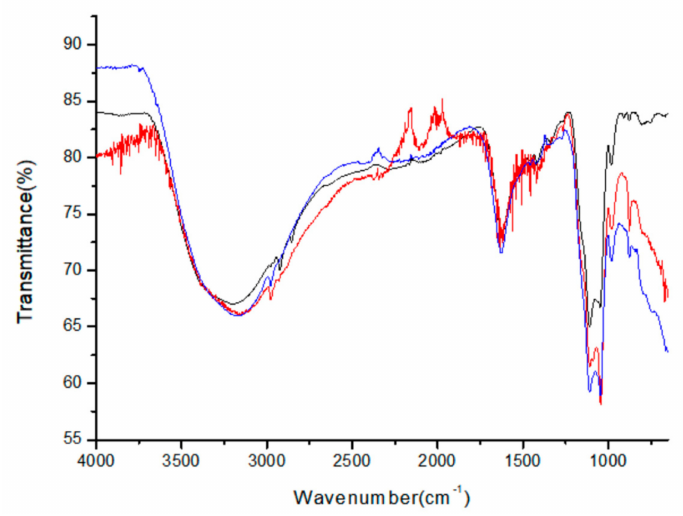
Figure 5. FT-IR spectra of Gly-ZnS:Mn (black), Ala-ZnS:Mn (red), and Val-ZnS:Mn (blue) NPs. The most characteristic peaks of the surface-capped amino acid molecules in each FT-IR spectrum were the two carbonyl (C=O) stretching peaks at 1550 and 1450 cm − 1 . This carbonyl stretching peak is very different from the peak (1700 cm − 1 ) of the corresponding amino-acid molecule in the free state, strongly suggesting that the carbonyl group is coor- dinated to the Zn 2+ or Mn 2+ ions on the surface of the nanocrystals. Moreover, the